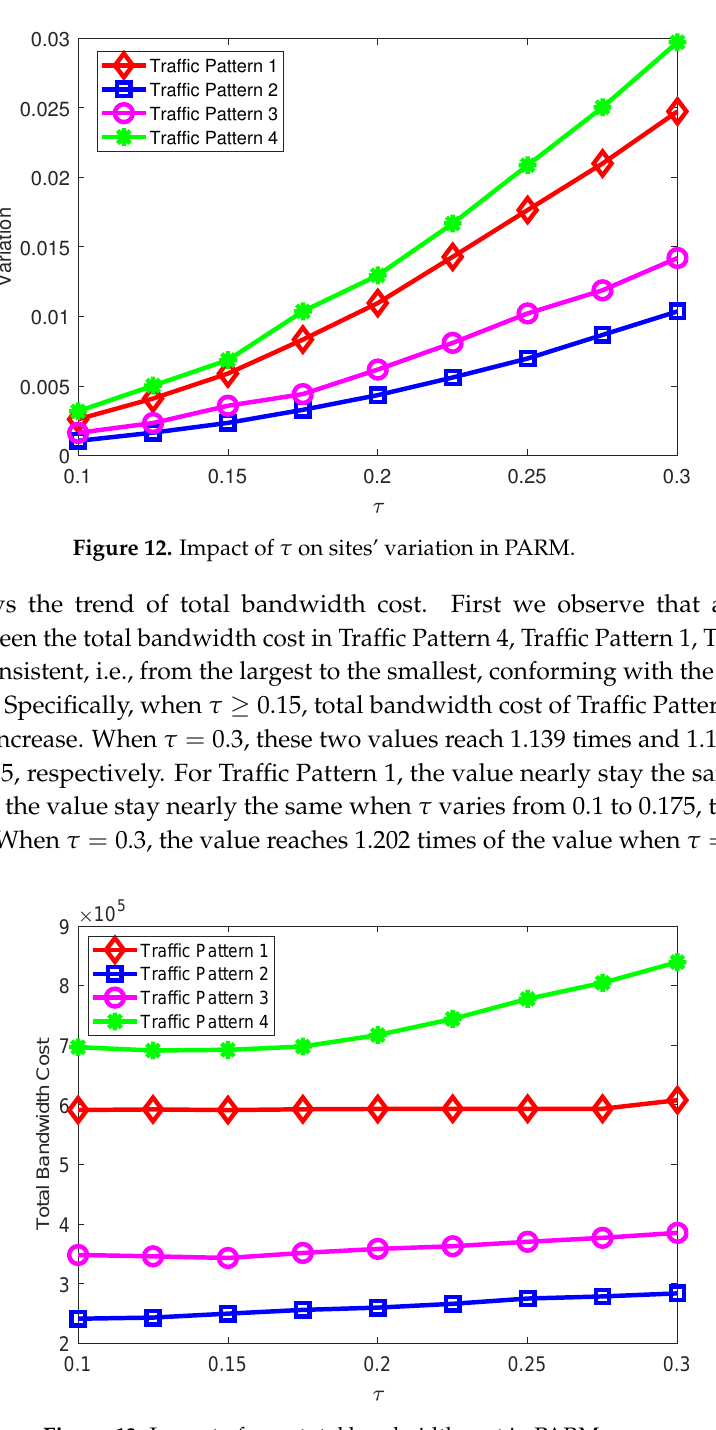
Figure 13. Impact of τ on total bandwidth cost in